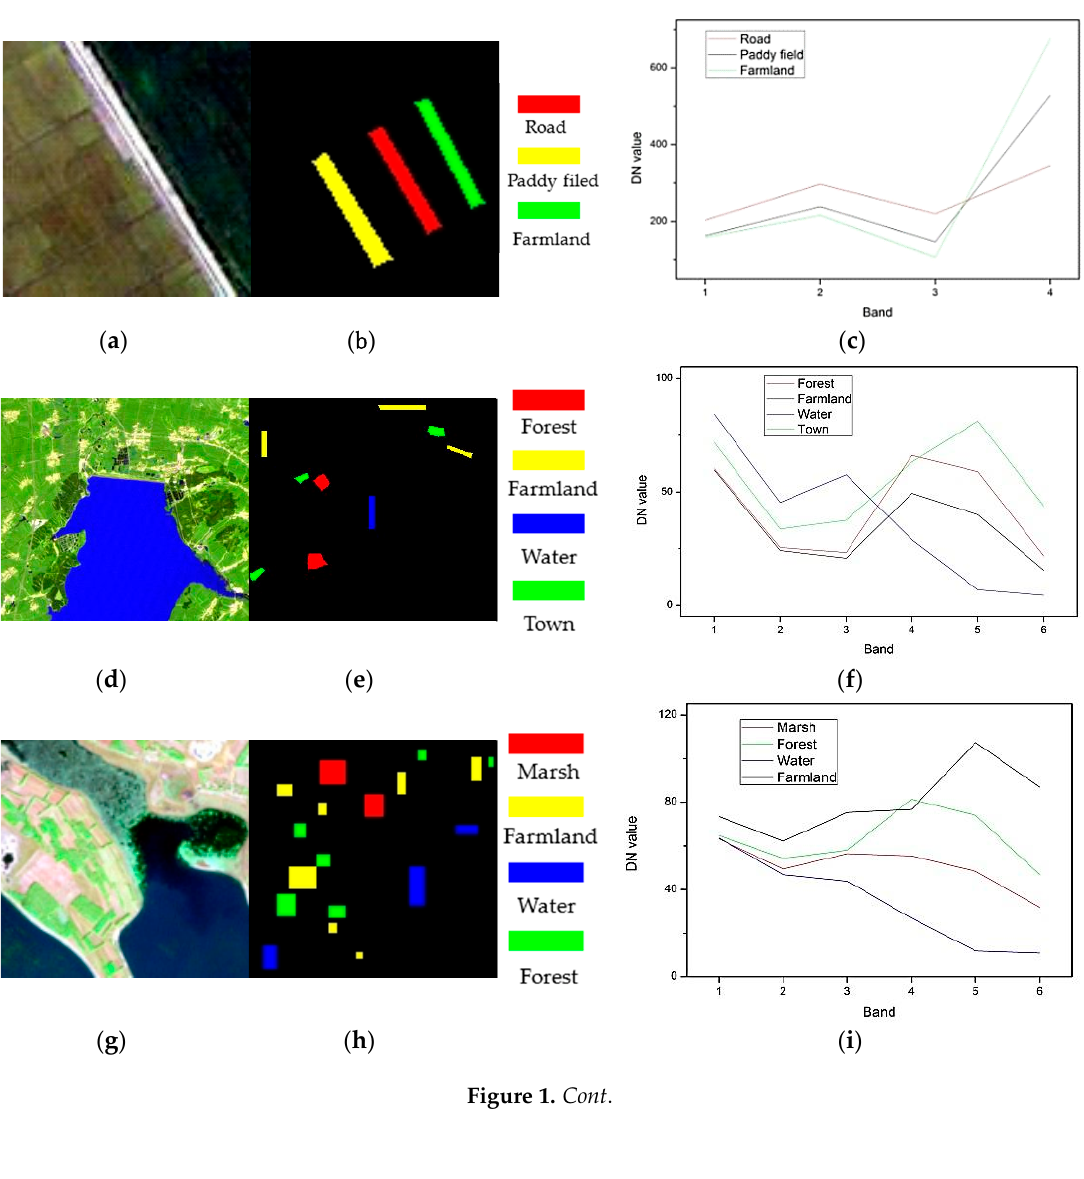
( o ) Figure 1. The multispectral images. ( a – c ) the true/false color map, the ground reference map and the corresponding spectral curves of ground truth classes of QuickBird datasets; ( d – f ) the corresponding maps of Landsat TM datasets; ( g – i ) the corresponding maps of Landsat ETM+ datasets; ( j – l ) the corresponding maps of GaoFen-1 datasets; ( m – o ) the corresponding maps of FLC1 datasets. ( a ) True color map; ( b ) false color map (7, 5, 3); ( c ) false color map (7, 5, 3); ( d ) true color map; and ( e ) false color map (bands 12, 9, and 1).